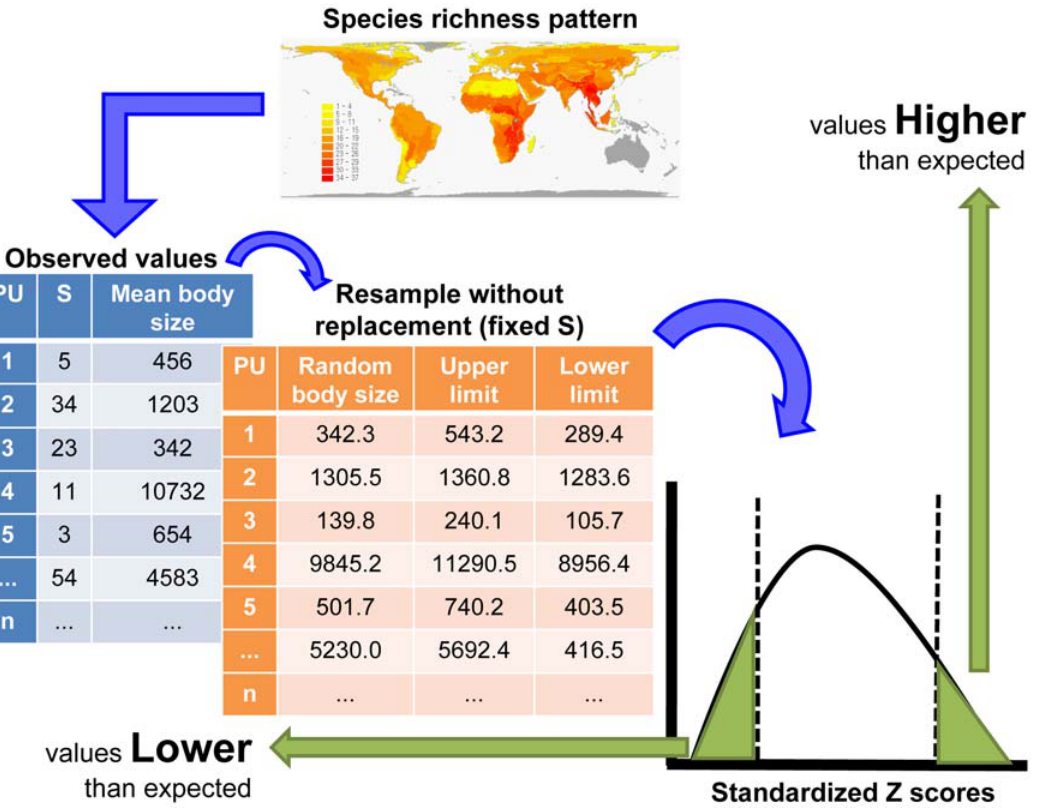
Figure 4. General randomization procedure used to generate vulnerability costs based on species biological traits. This was done this way: for each ecoregion we calculated the mean value of a particular biological trait (e.g. body size) based on the species occurring there – see the pattern of species richness on the upper part of the figure. Then, we resampled without replacement the same number of species found in the ecoregion from the species pool in order to calculate an expected mean value for each biological trait included in this study. This was done 1000 times, and the expected distributions of trait values were compared with those actually observed within each ecoregion. We were then able to evaluate if a given ecoregion had trait values higher or lower then we would expect if species were able to occupy all the geographical space. These values were submitted to a statistical z transformation in order to be compared and analyzed together.